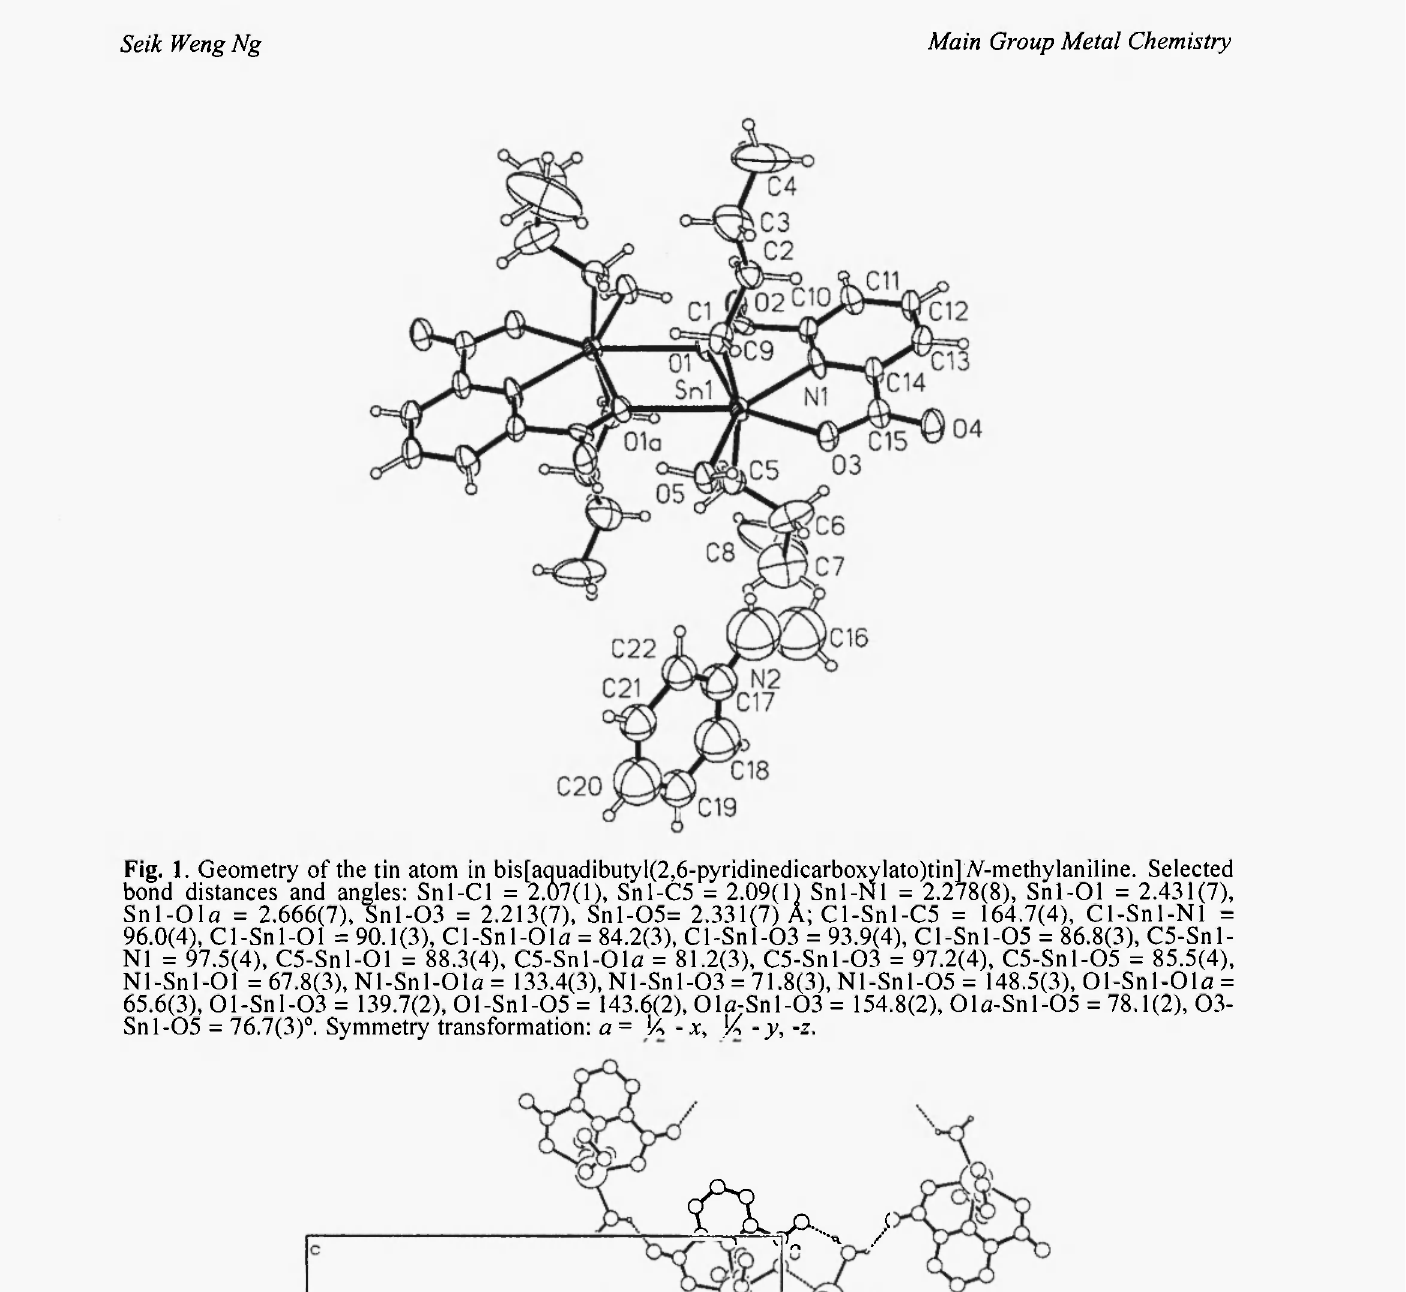
Fig. 1. Geometry of the tin atom in bis[aquadibutyl(2,6-pyridinedicarboxylato)tin]7V-methylaniline. Selected bond distances and angles: Snl-Cl = 2.07(1), Snl-C5 = 2.09(1) Snl-Nl = 2.278(8), Snl-Ol = 2.431(7), Snl-Ola = 2.666(7), Sn 1-03 = 2.213(7), Snl-05= 2.331(7) A; Cl-Snl-C5 = 164.7(4), Cl-Snl-Nl = 96.0(4), CI-Snl-Ol = 90.1(3), CI-Snl-Ol α = 84.2(3), Cl-Snl-03 = 93.9(4), Cl-Snl-05 = 86.8(3), C5-Snl- N1 = 97.5(4), C5-Snl-01 = 88.3(4), C5-Snl-01a = 81.2(3), C5-Snl-03 = 97.2(4), C5-Snl-05 = 85.5(4), Nl-Snl-Ol = 67.8(3), Nl-Snl-ΟΙα = 133.4(3), Nl-Snl-03 = 71.8(3), Nl-Snl-05 = 148.5(3), Ol-Snl-Ola = 65.6(3), 01-Snl-03 = 139.7(2), 01-Snl-05 = 143.6(2), 01a-Snl-03 = 154.8(2), 01a-Snl-05 = 78.1(2), 03- Snl-05 = 76.7(3)°. Symmetry transformation: a= \A - χ, [ λ -y,-z.